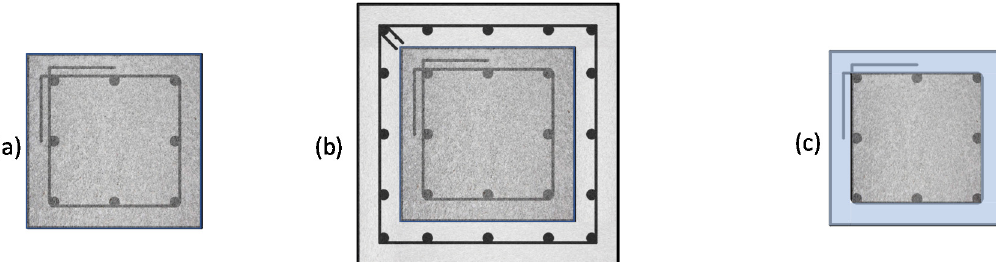
Figure 1. ( a ) Deficient cross-section; ( b ) Retrofit with reinforced concrete jacket; ( c ) Retrofit with cover replacement using SHCC.